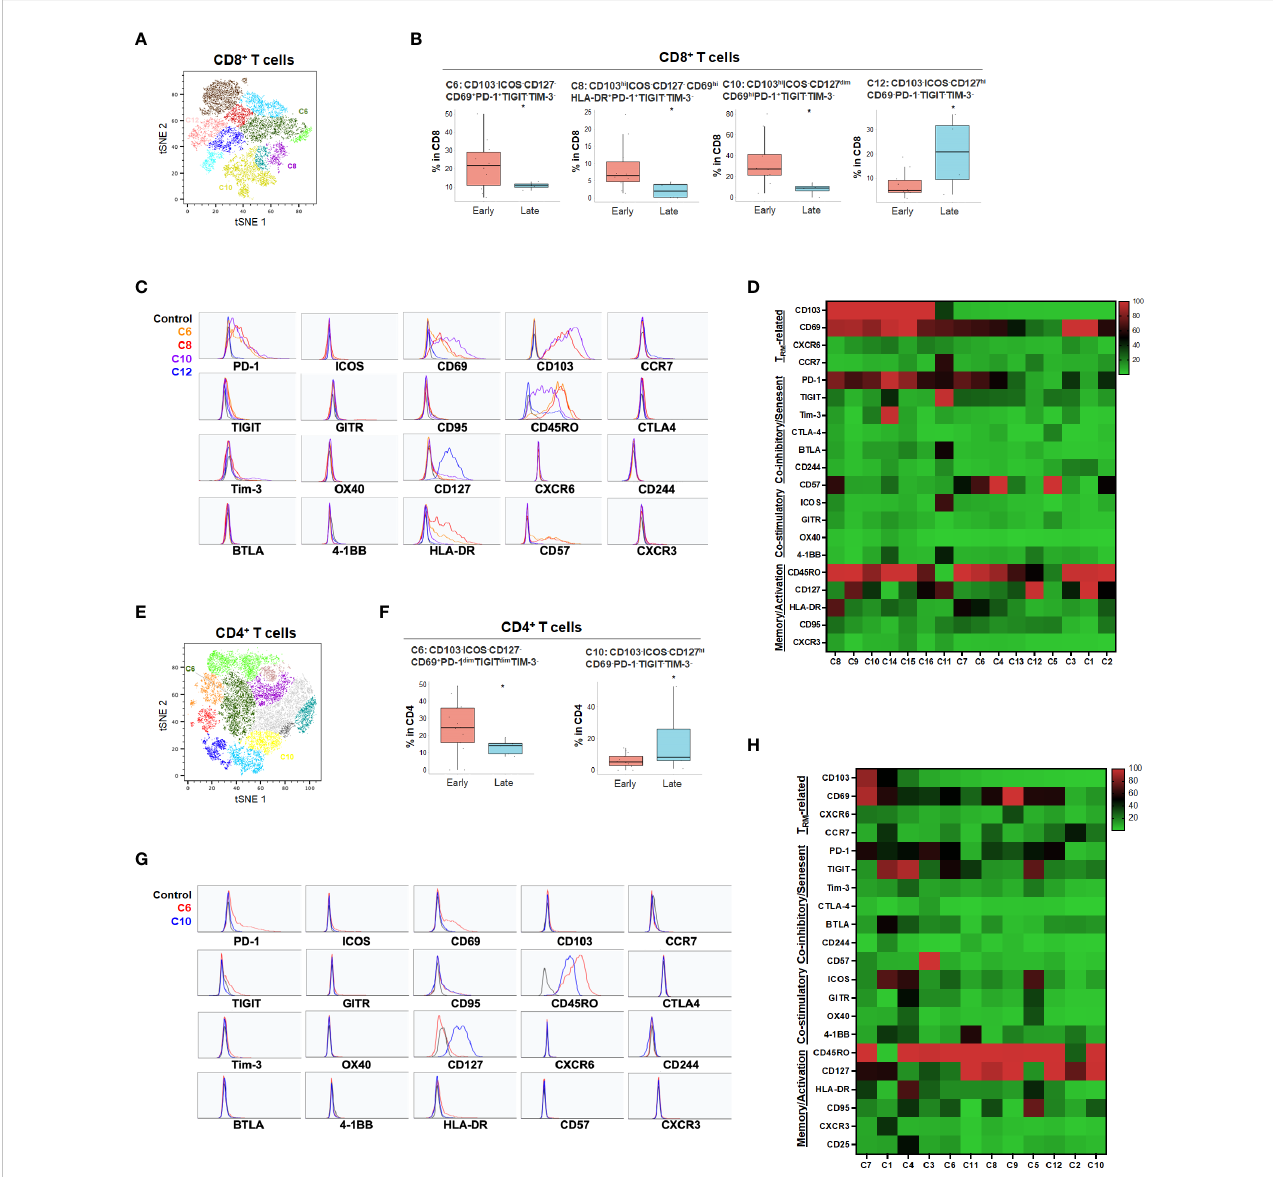
FIGURE 5 PDA disease stage and effect on T cell phenotypes (A) tSNE projection of CD8+ T cells showing 16 manual-gated clusters identi fi ed from early stage (n=11) and late stage (n=4) PDA patients. Signi fi cantly enriched clusters in early stage (C6, C8, C10) and late stage (C12) PDA patients are labeled. (B) Boxplots showing percentage of early stage-enriched CD8+ T cell clusters and late stage-enriched clusters. Box middle lines, median; box limits upper and lower quartiles; box whiskers, 1.5x the interquartile range. *p < 0.05, Kruskal-Wallis test. (C) Histograms showing individual marker expression of early stage-enriched CD8+ T cell clusters in C6 (orange), C8 (red), C10 (purple) and late stage-enriched cluster C12 (blue). (D) Expression of TRM-related markers, co-inhibitory/senescent markers, co-stimulatory markers and memory/activation markers in 16 clusters of CD8+ T cells is shown in heatmap which is arranged based on the expression level of CD103. (E) tSNE projection of CD4+ T cells showing 12 manual-gated clusters identi fi ed from early stage (n=13) and late stage (n=5) PDA patients. Signi fi cantly enriched clusters in early stage (C6) and late stage (C10) PDA patients are labeled. (F) Boxplots showing percentage of early stage-enriched CD4+ T cell cluster C6 and late stage-enriched cluster C10. Box middle lines, median; box limits upper and lower quartiles; box whiskers, 1.5x the interquartile range. *p < 0.05, Kruskal-Wallis test. (G) Histograms showing the individual marker expression of early stage-enriched CD4+ T cell clusters C6 (red) and late stage-enriched clusters C10 (blue). (H) Expression of TRM-related markers, co- inhibitory/senescent markers, co-stimulatory markers and memory/activation markers in 12 clusters of CD4+ T cells is shown in heatmap which is arranged based on the expression level of